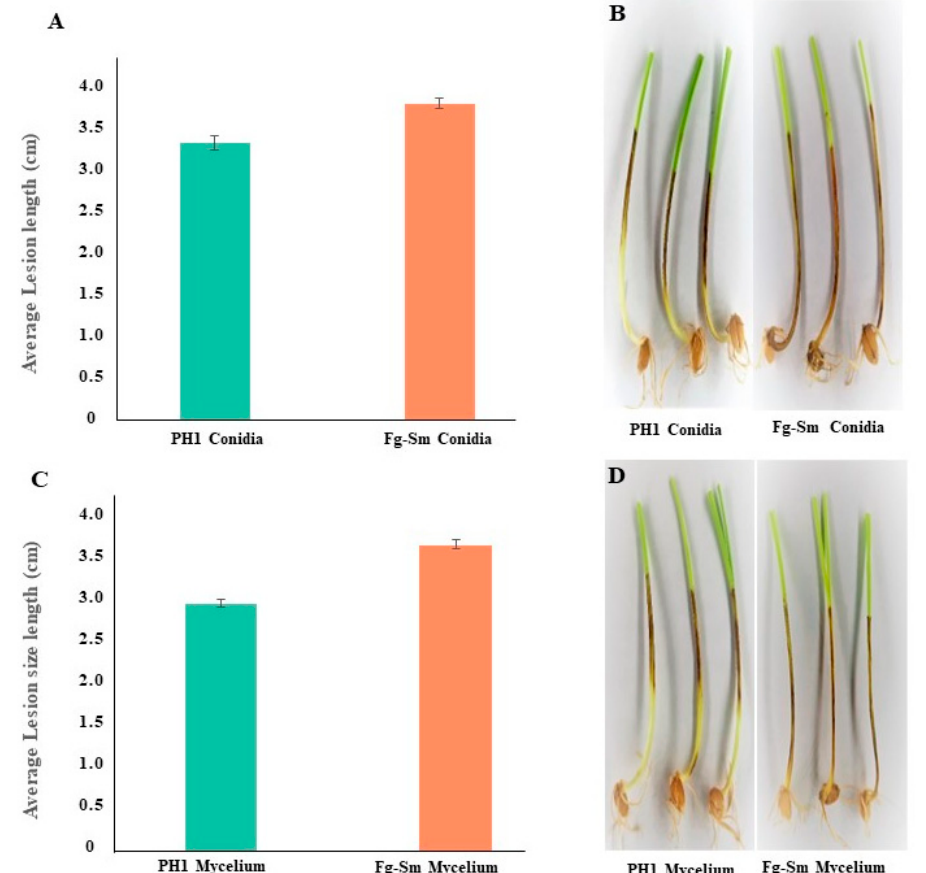
Figure 4. Pathogenicity assay of wheat coleoptiles infected with conidia and mycelium of the Fg- S. maltophilia (Fg-Sm) isolate and PH-1. ( A ) Lesion length measurements of coleoptiles infected with conidia ( t -test same average p = 0.0010). ( B ) Coleoptiles with lesions infected with a conidial suspension of PH1 and Fg-Sm isolate. ( C ) Lesion length measurements of coleoptiles infected with mycelium ( t -test same average p = 0.00011). ( D ) Coleoptiles with lesions infected with mycelium of PH1 and Fg-Sm isolate. Error bars show 95% confidence intervals. Non-overlapping confidence interval bars are significantly different ( p same < 0.05).